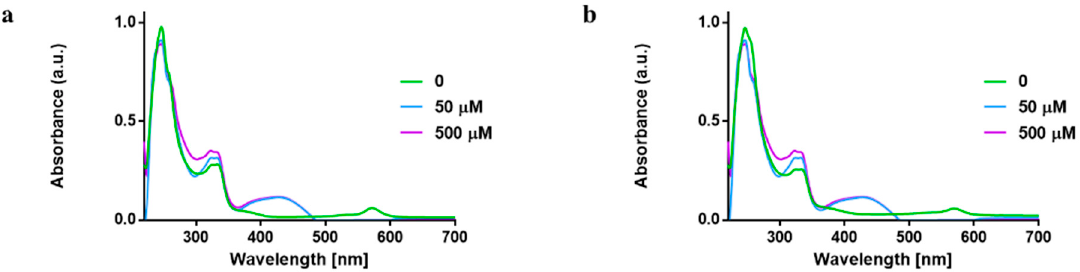
Figure 4. UV–vis spectra showing reaction of L -glutathione with ( a ) 1 and ( b ) 2 in RPMI at 37 °C at different concentration.